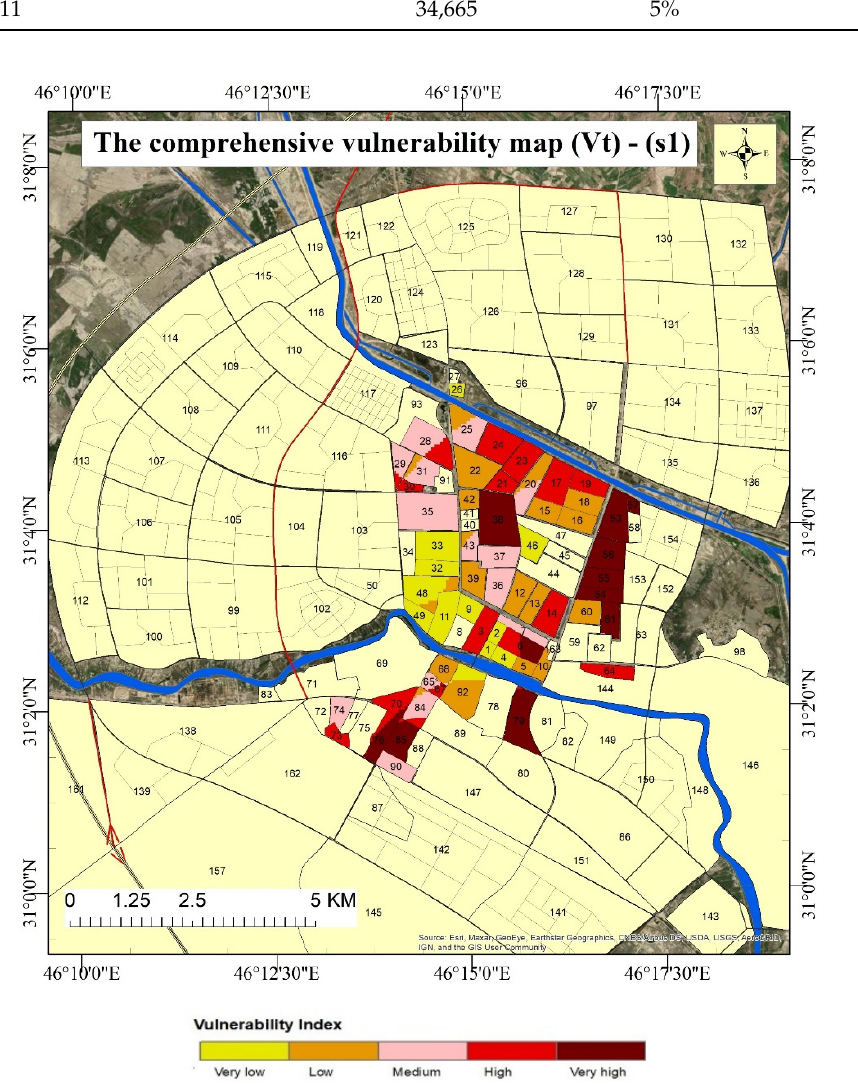
Figure 21. First classification scenario of city neighbourhoods based on the comprehensive vulner- ability index (Vt).